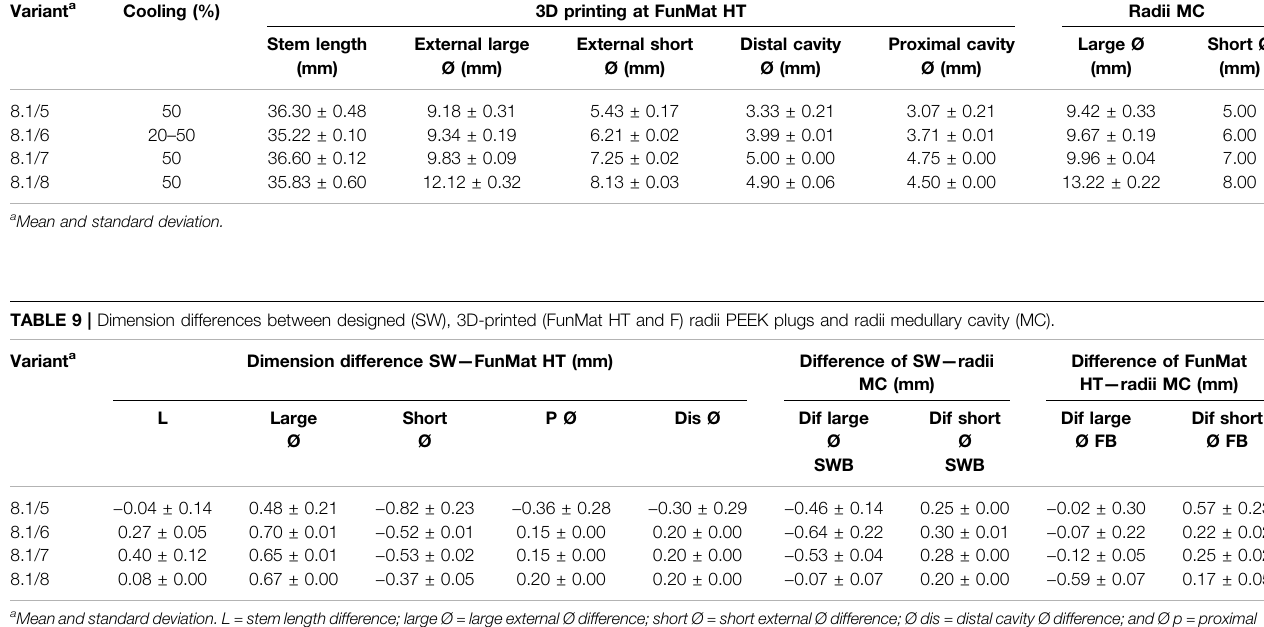
TABLE 10 | 3D-printed (FunMat) dimensions and their corresponding bone anchorage and thread strength values for all 8.1/6 subcategories (8.1/6